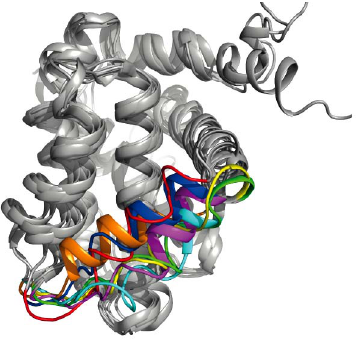
Figure 7. PDB structures of Bcl-xL in free and complexed states. Helix a 3 that moves upon ligand binding is coloured differently for the ligand-bound structures (1YSG, red; 2O2M, blue and 2YXJ, purple), for the peptide-bound structures (1G5J, cyan; 1BXL, yellow and 2PON, green), and for the free structure (1R2D, orange).